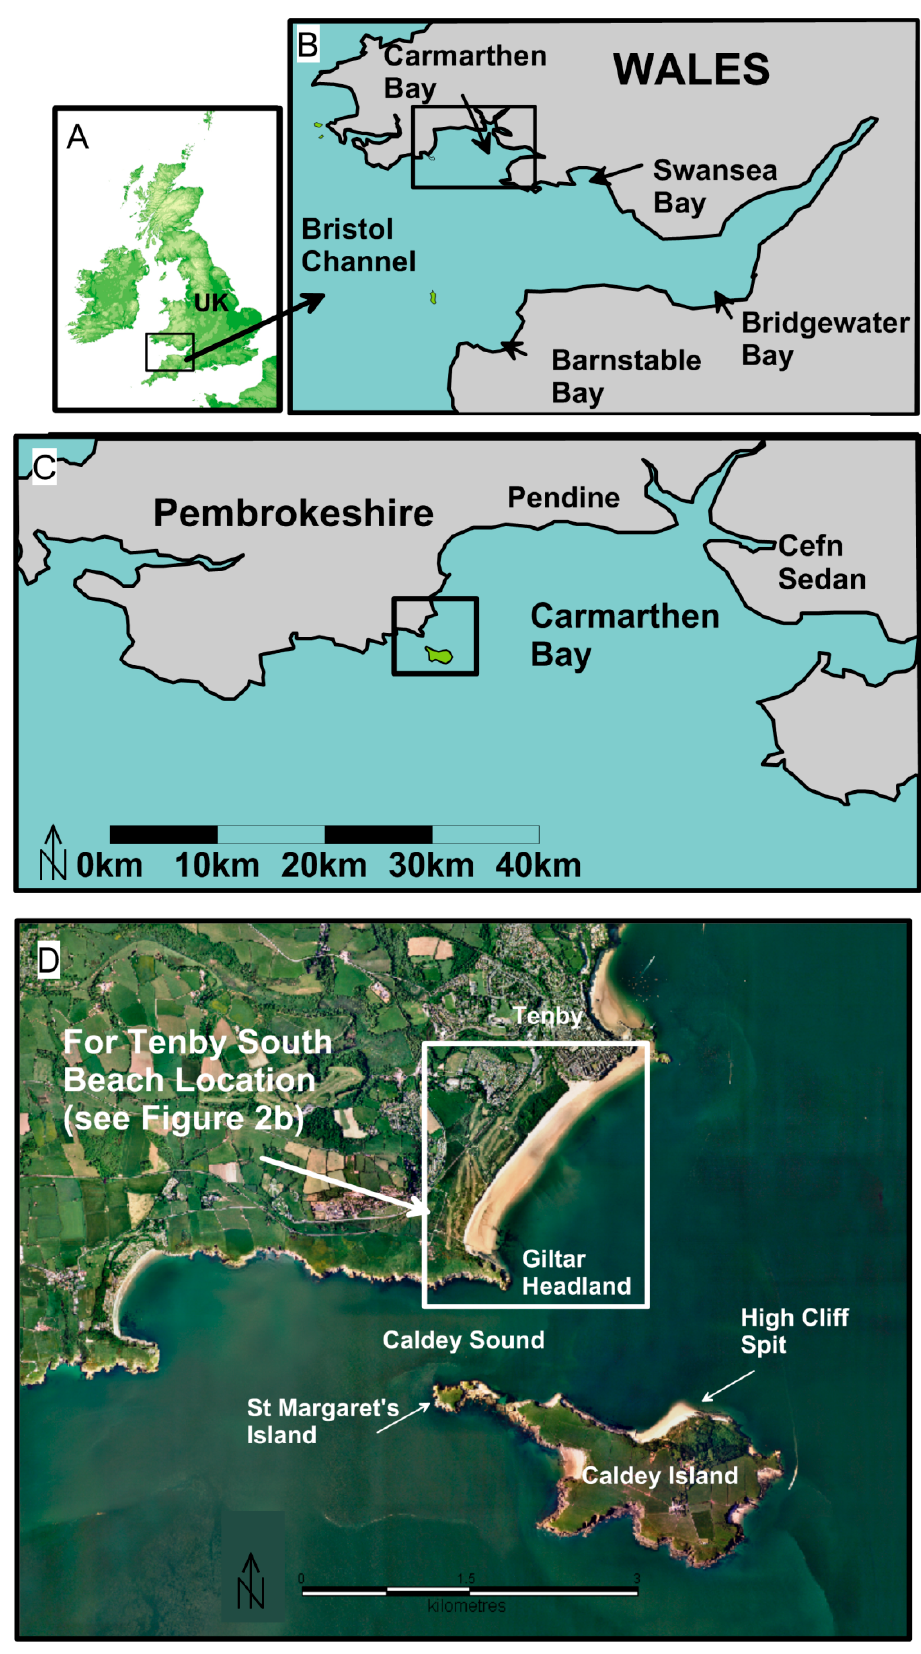
Figure 1. Locality of the study area, ( A ) United Kingdom; ( B ) Bristol Channel ( C ) Carmarthen Bay and ( D ) The study region.